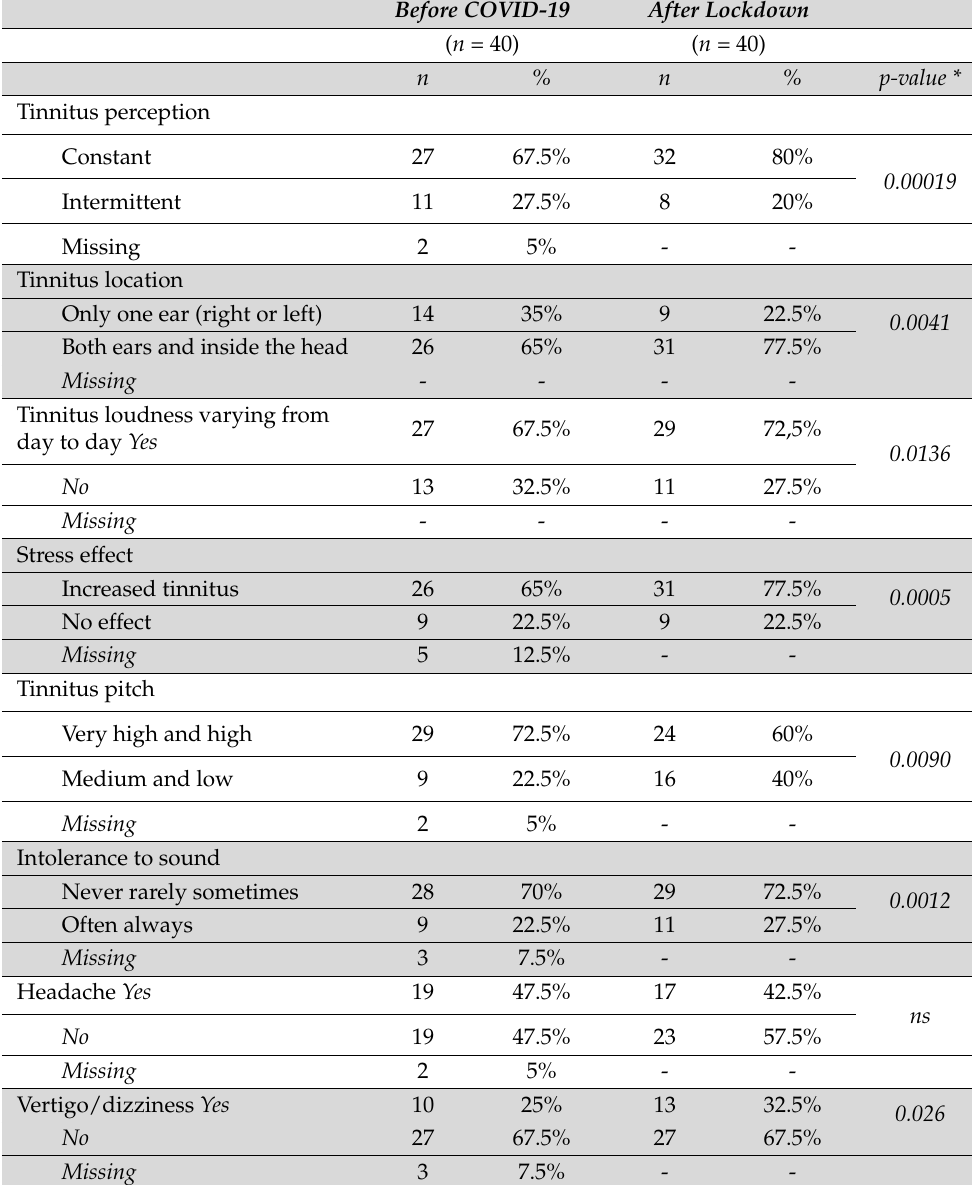
Table 1. Sociodemographic and clinical data before COVID-19 and after